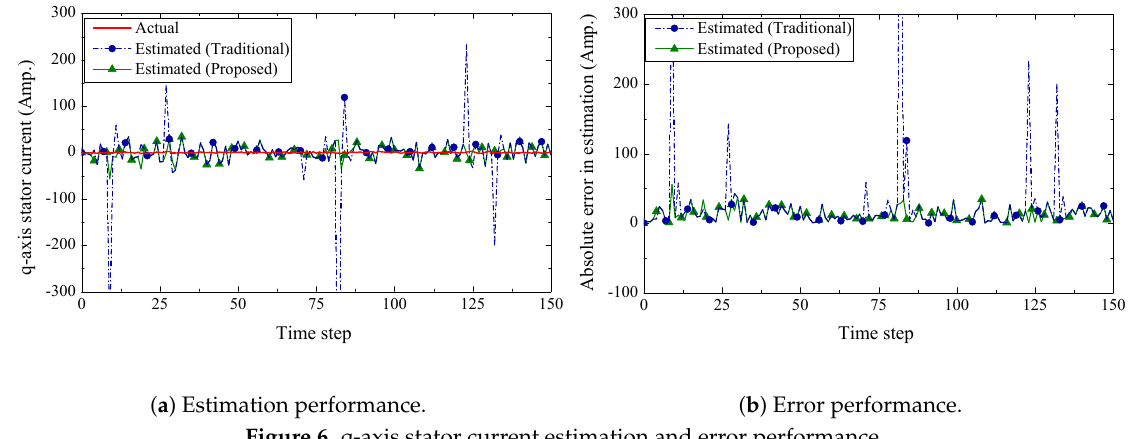
Figure 5. d-axis stator current estimation and error performance.